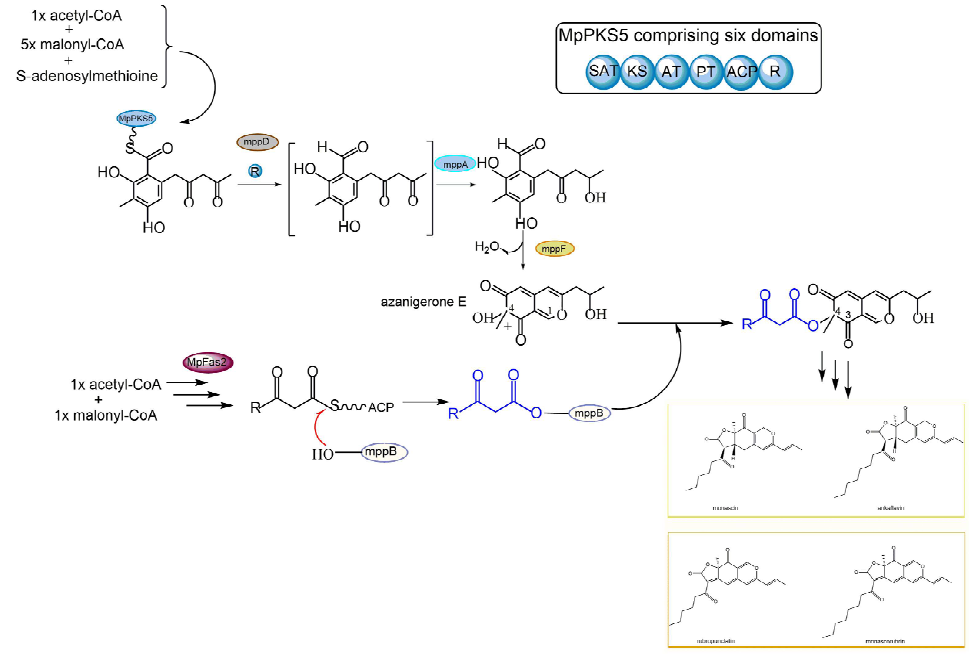
Figure 4. Schematic diagram of various azaphilone pigment biosynthesis via polyketide synthase (PKS) pathway and fatty acid synthase (FAS) pathway in Monascus purpureus.